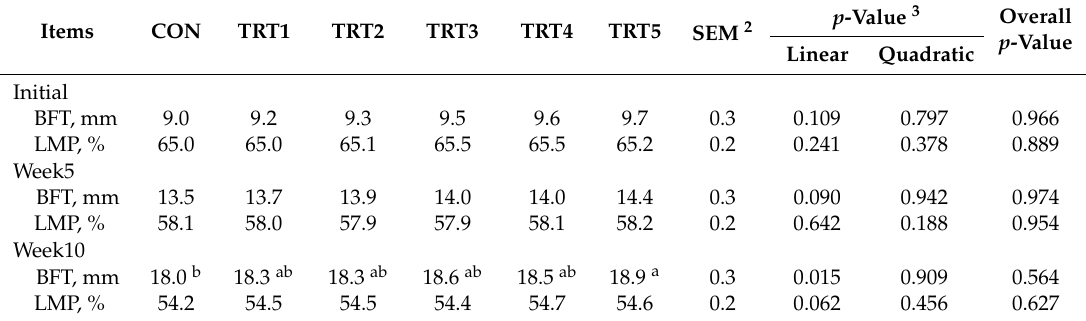
Table 6. The e ff ect of black pepper supplementation on backfat thickness and lean meat percentage (LMP) of finishing pigs 1 .